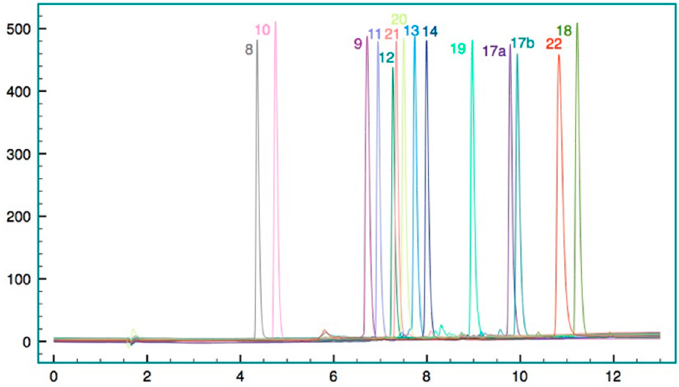
Figure 5. Superimposition of the analytical HPLC of peptides 8 to 22 on a C18 column, using as eluting gradient H 2 O containing 0.1% TFA with 5% to 100% with MeCN containing 0.1% TFA.